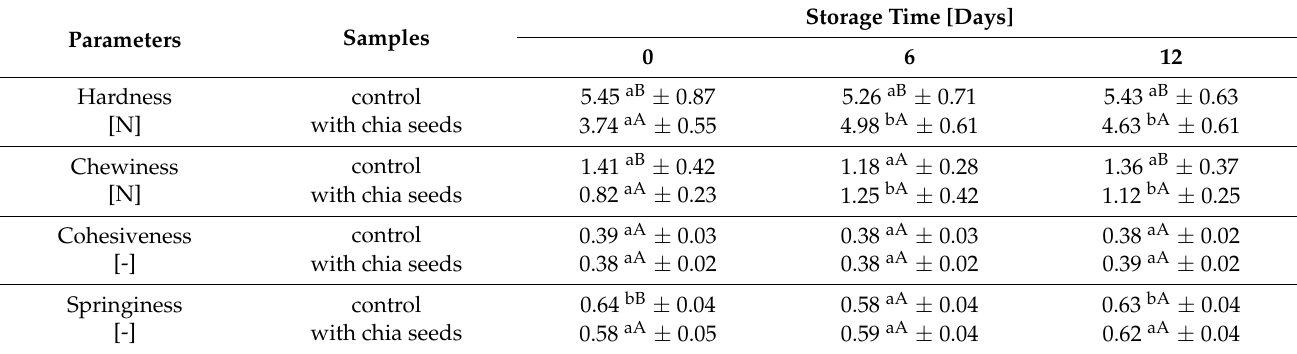
Table 4. Effect of chia seeds and storage time on the texture parameters of pork patties (mean ± SD).